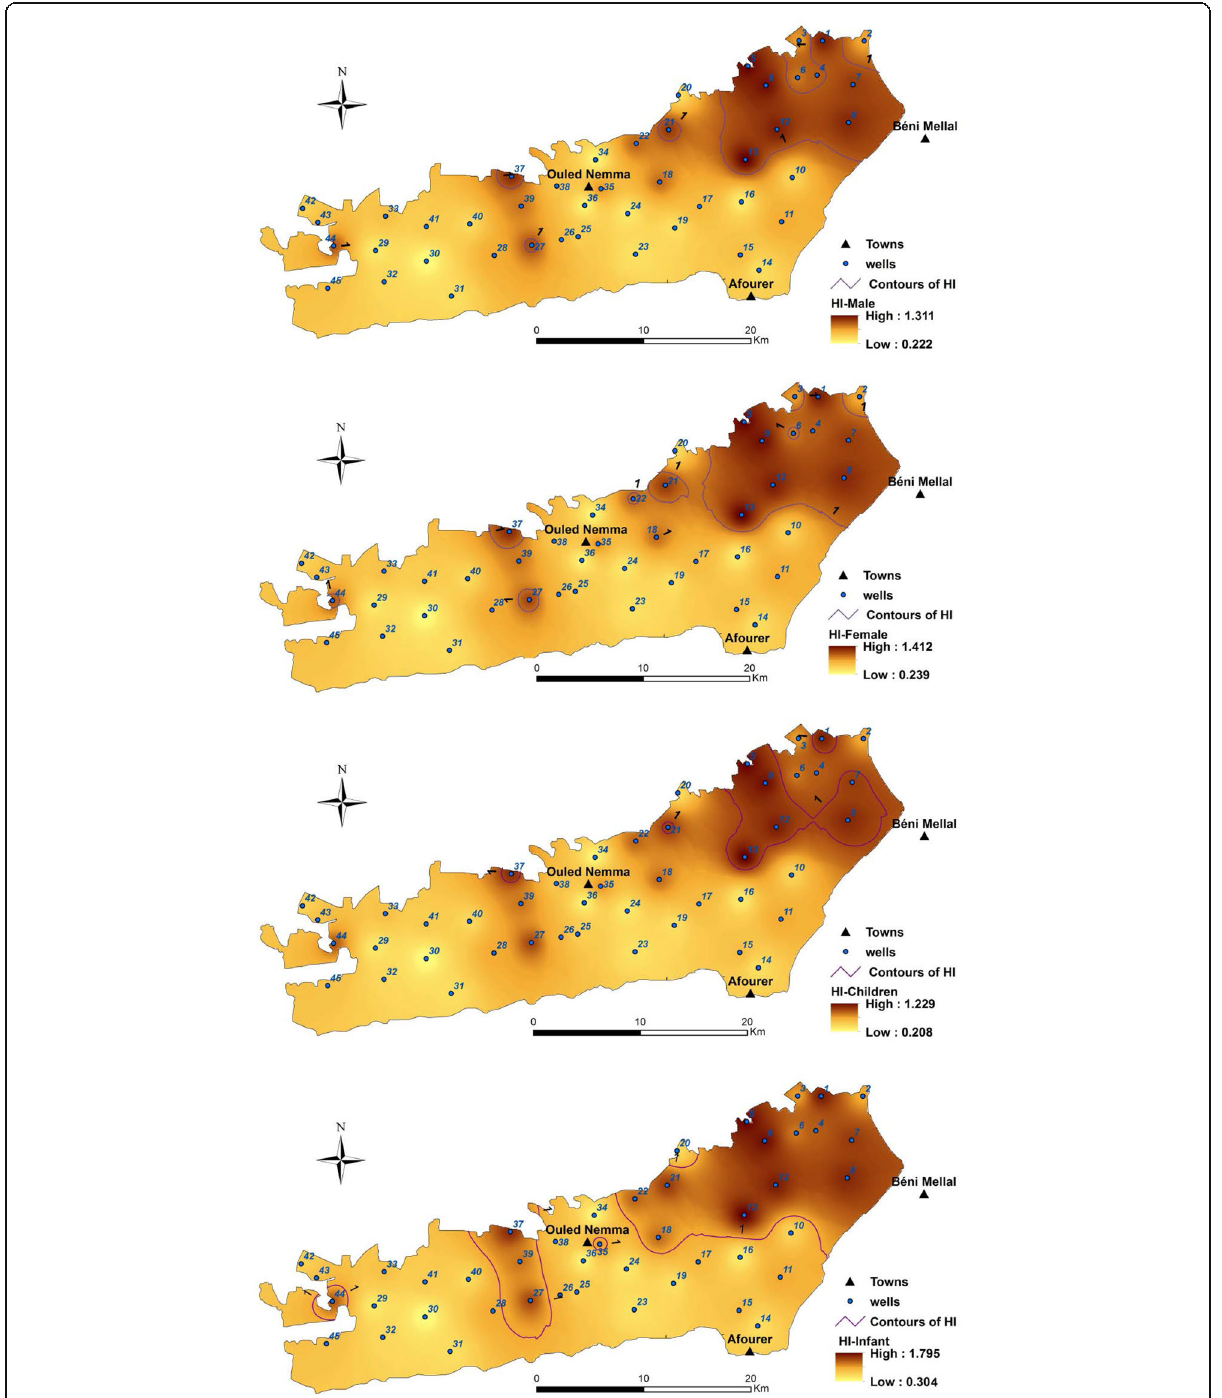
Fig. 5 Spatial distribution of non-carcinogenic risk of NO 3 for male, female, children, and